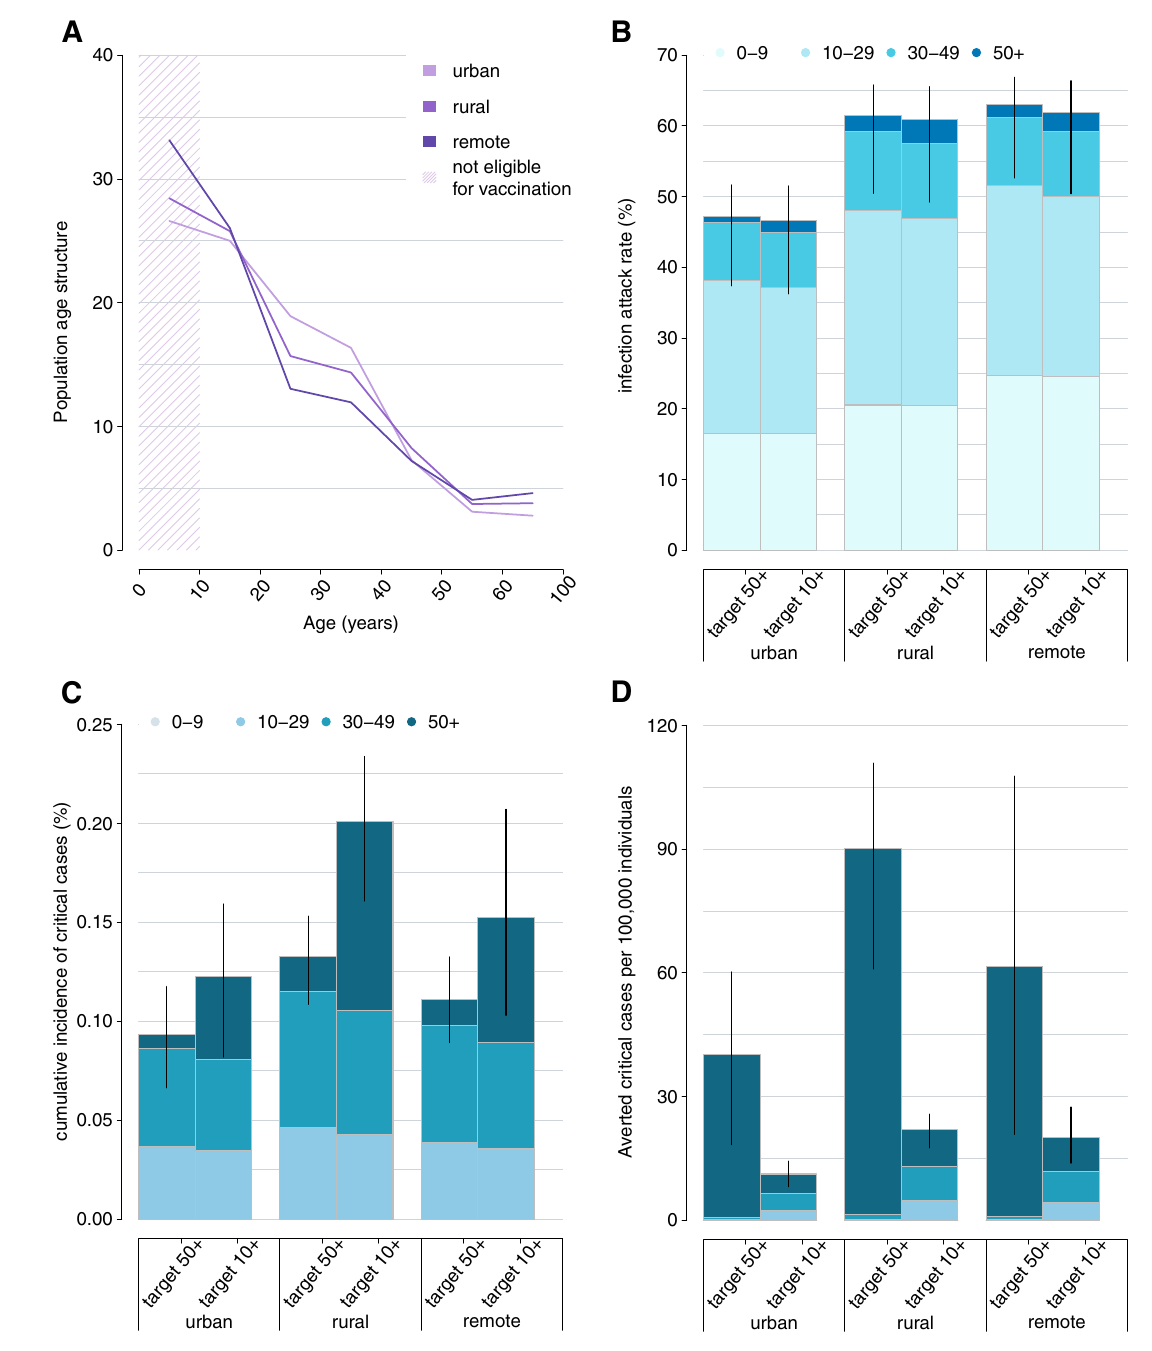
Figure 3. (A) Population age structure in urban, rural, and remote settings of the SWSZ. The shaded area highlights the age segments of the population who are not yet eligible for COVID-19 vaccination. ( B – D ) Infection attack rate, cumulative incidence of critical cases, and averted critical cases per 100,000 residents as estimated for different geographical contexts (urban, rural, and remote) under the assumption that either all the individuals aged 50 years or older are vaccinated or that the same number of vaccine doses is uniformly distributed throughout the population over 10 years. Therefore, an equal number of people is assumed to be vaccinated in the two scenarios. Bars represent average estimates, stratified by the age group of infected individuals (0–9, 10–29, 30–49, 50+ years); solid lines represent the 95% PI of model